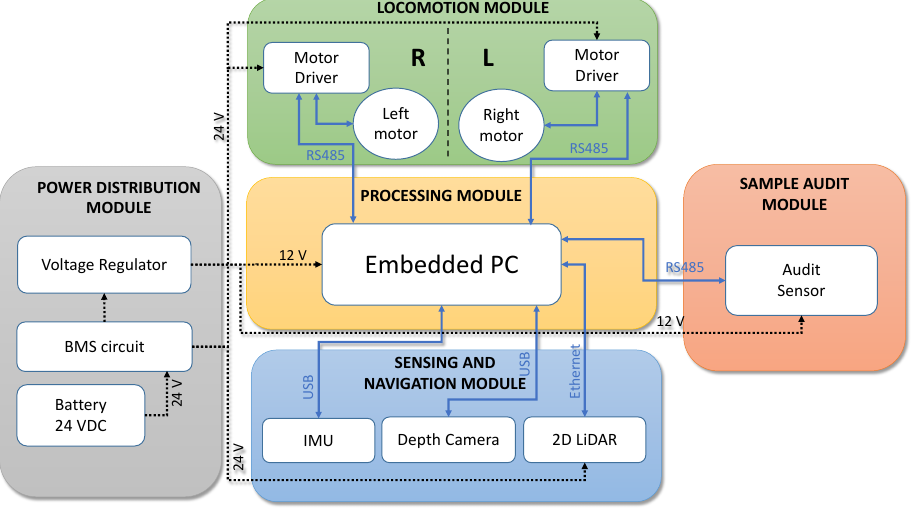
Figure 3. The system architecture of the BELUGA robot with the main